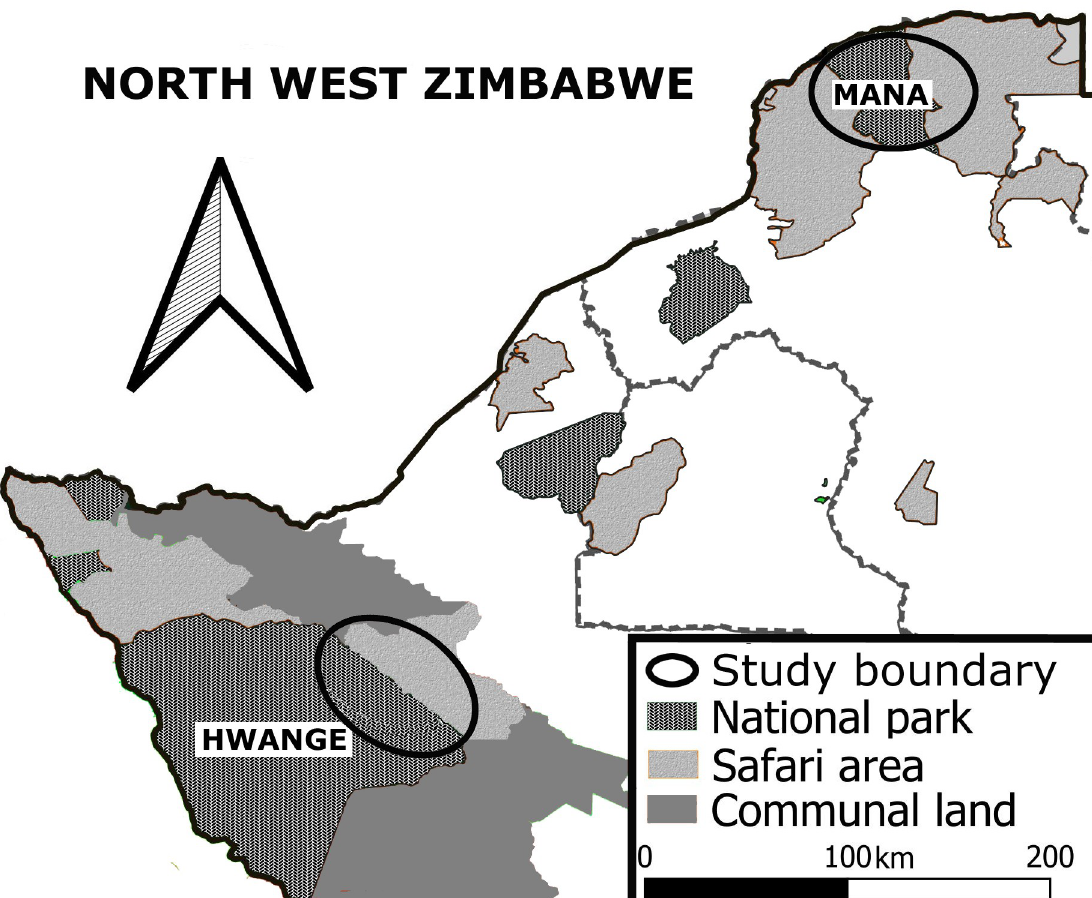
Fig 1. General locations of Hwange National Park and Mana Pools National Park in